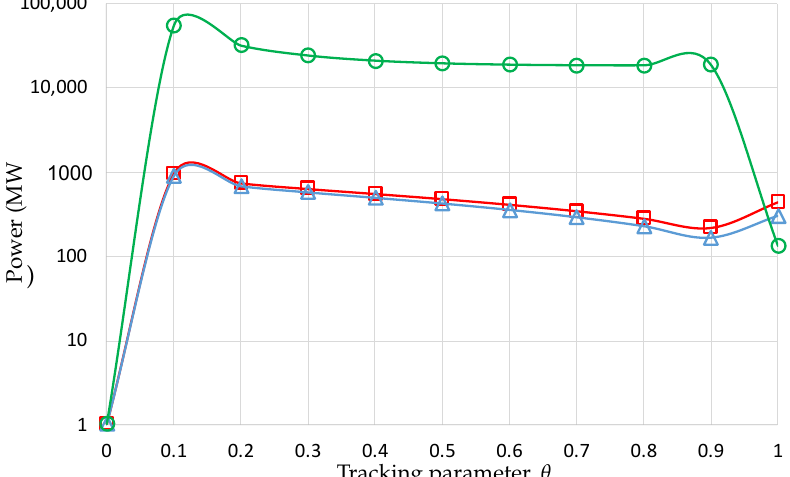
Figure 3. Trajectory of the roots (solutions) during the minimization of the fuel cost objective function with the NPHC algorithm. Red squares represent x 1 , blue triangles represent x 2 , and green circles represent x 3